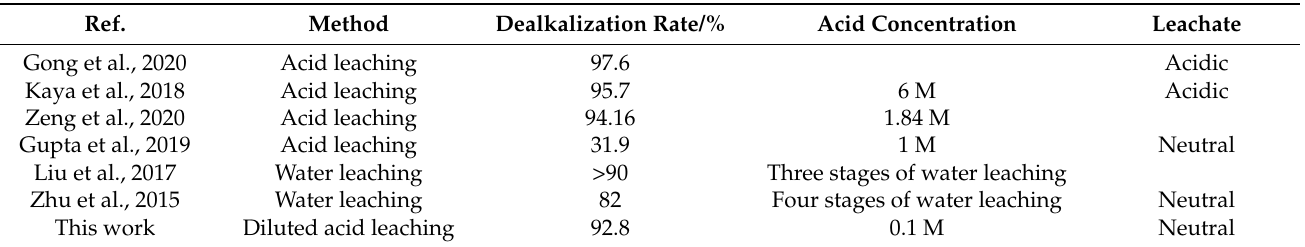
Table 4. Comparison of the dealkalization rate and leaching condition between diluted acid leaching and traditional acid or water leaching.